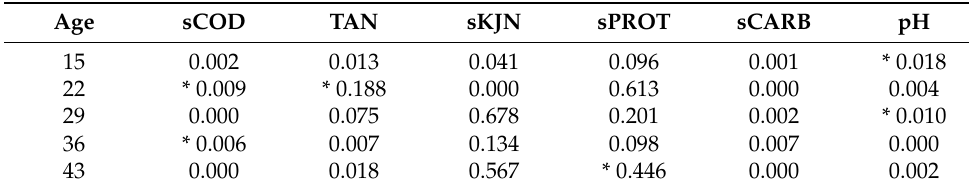
Table 4. Results of the ANOVA of the biochemical parameters factored per age. Bold p -values are